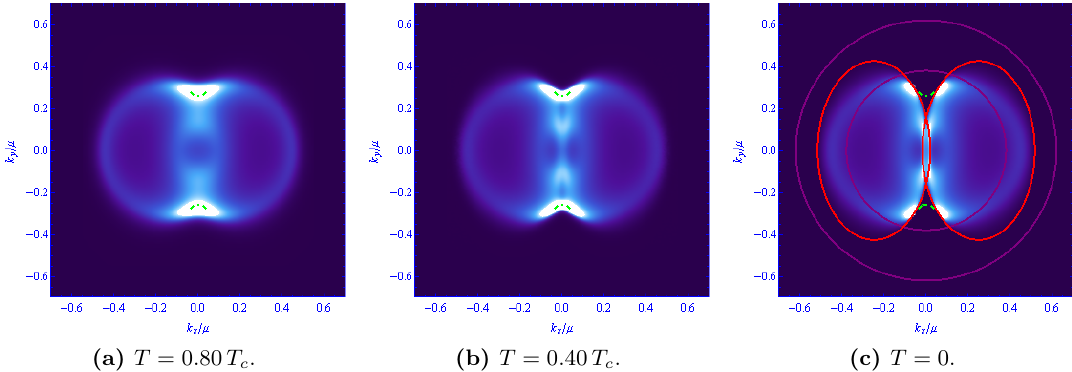
Figure 13. The spectral function for di(cid:11)erent temperatures and (cid:12)xed (cid:21) = 0 : 80 > (cid:21) c , ! = 0 : 12 (cid:22) . It remains almost unchanged for the entire range of the temperatures. The purple and red circles represent the UV and IR Dirac cones